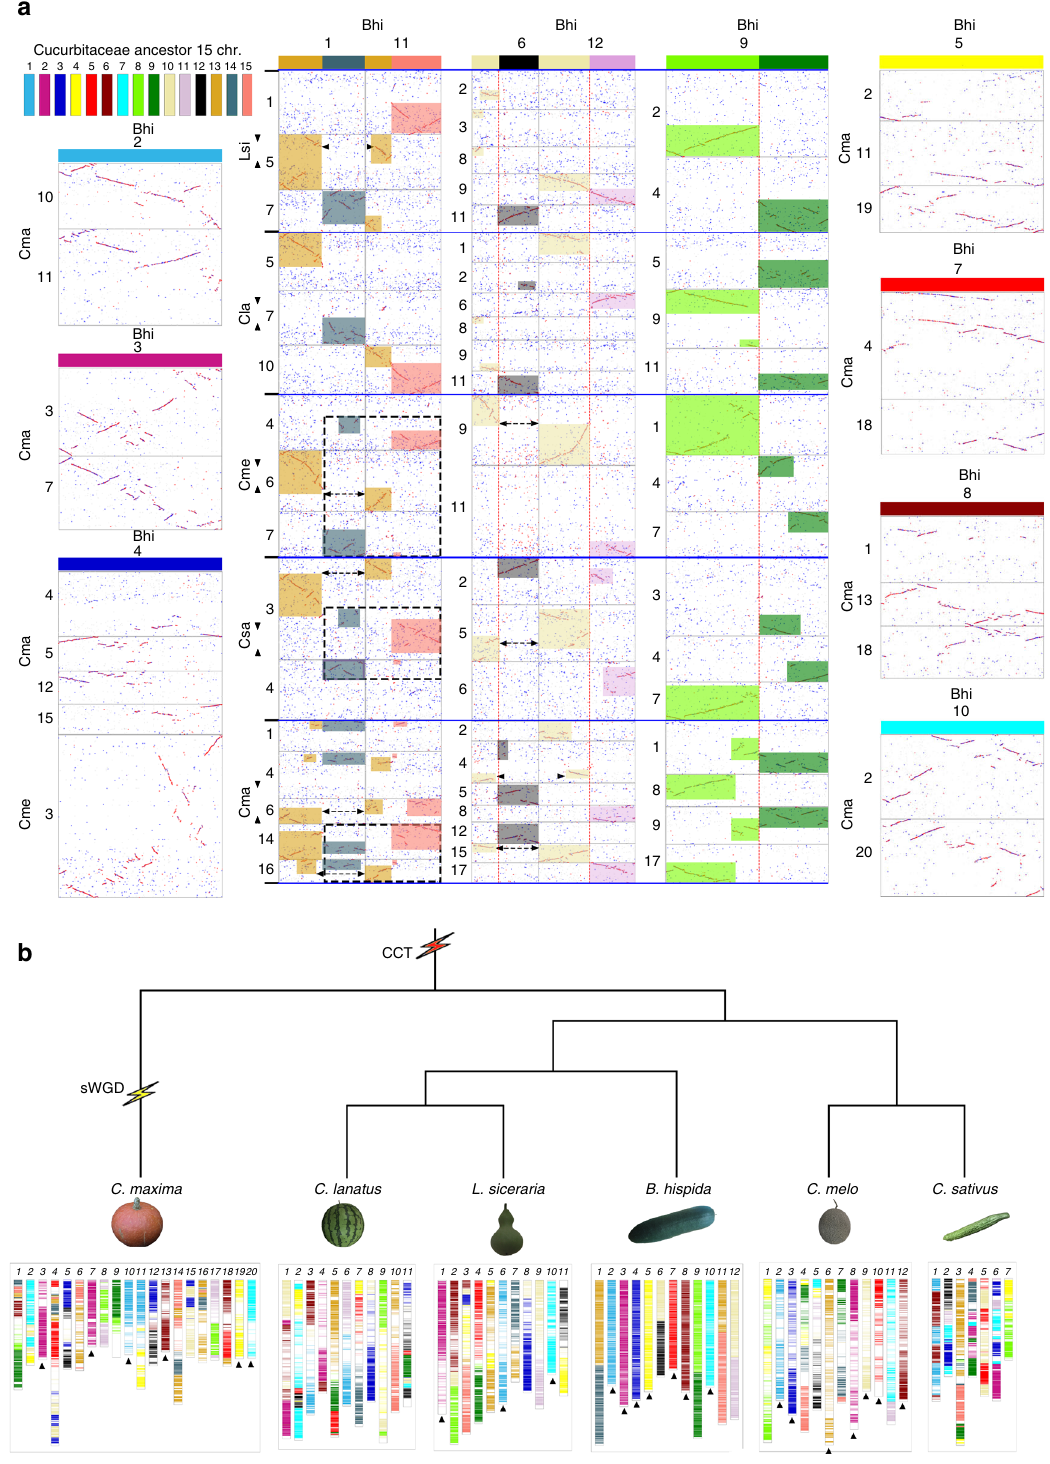
Fig. 2 Genome evolution of the six sequenced cucurbit species. a Conserved genome karyotype of wax gourd and identi fi cation of ancestral chromosomes of cucurbit species. Different colors along the 12 wax gourd chromosomes indicate the origin of the 15 ancestral chromosomes. Bhi: Benincasa hispida ; Cma: Cucurbit maxima ; Cme: Cucumis melo ; Lsi: Lagenaria siceraria ; Cla: Citrullus lanatus ; Csa: Cucumis sativus . b Evolutionary scenario of the Cucurbitaceae genomes from the ancestral Cucurbitaceae karyotype. sWGD: speci fi c whole-genome duplication; CCT: cucurbit-common